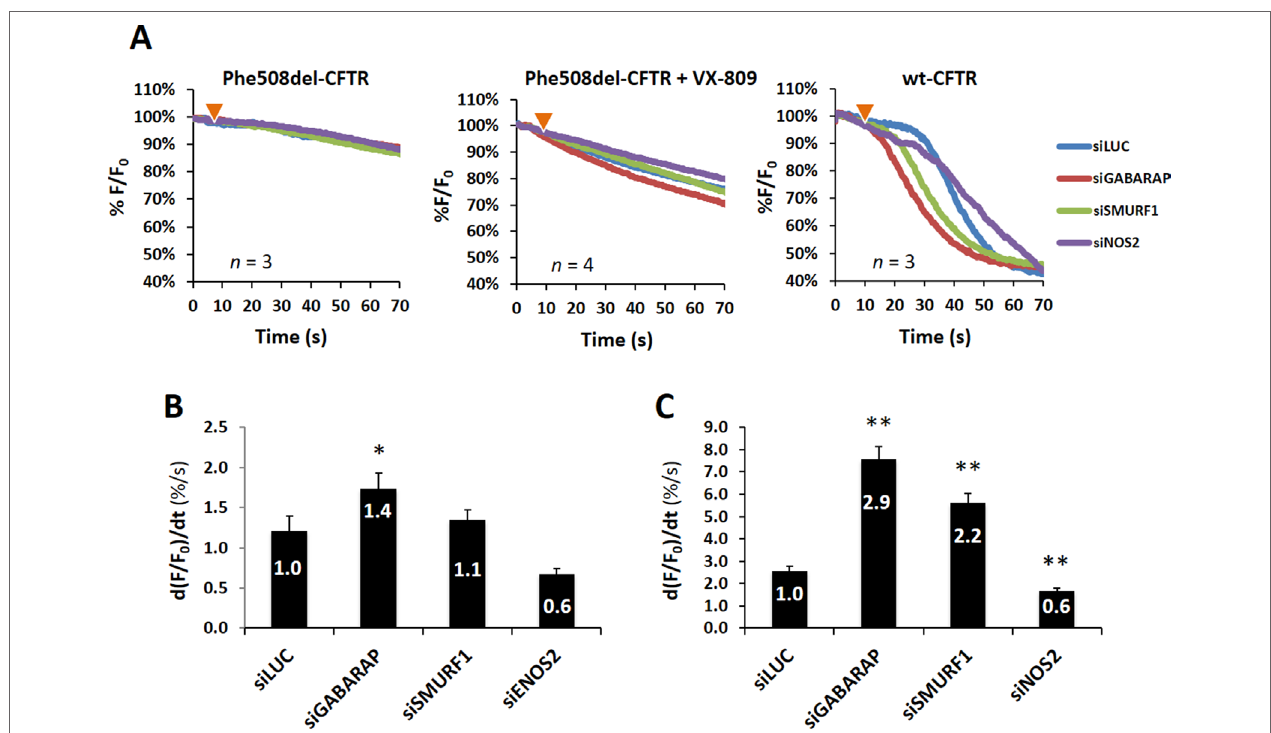
FIGURE 3 | Knockdown of selected candidate proteins influences wt- and F508del-CFTR function. (A) Representative fluorescence decay curves of the iodide influx assay. Wt- or F508del-CFBE cells stably expressing the HS-YFP sensor were transfected and treated for 48 h, as indicated. Fluorescence microscopy images were acquired continuously, first for 10 s (baseline) and then for 60 s after the rapid (≤1 s) addition of isosmotic buffer, containing 100 mM iodide together with either 5 μM Fsk (wt-CFTR cells) or 5 μM Fsk plus 20 μM Gen (F508del-CFTR cells). (B) Iodide influx rates from VX-809-treated (3 μM, 48 h) F508del-CFTR cells, transfected with the indicated siRNAs. The average fluorescence decay was fitted to an exponential decay function to derive the maximal slope [d( F / F 0 )/d t , at t = 0] that is proportional to the initial influx of I − into the cells. (C) Iodide influx rates, calculated as in (B) , for wt-CFTR CFBE cells, transfected as indicated. Data are means ± SEM of three independent assays. * p < 0.05; ** p <